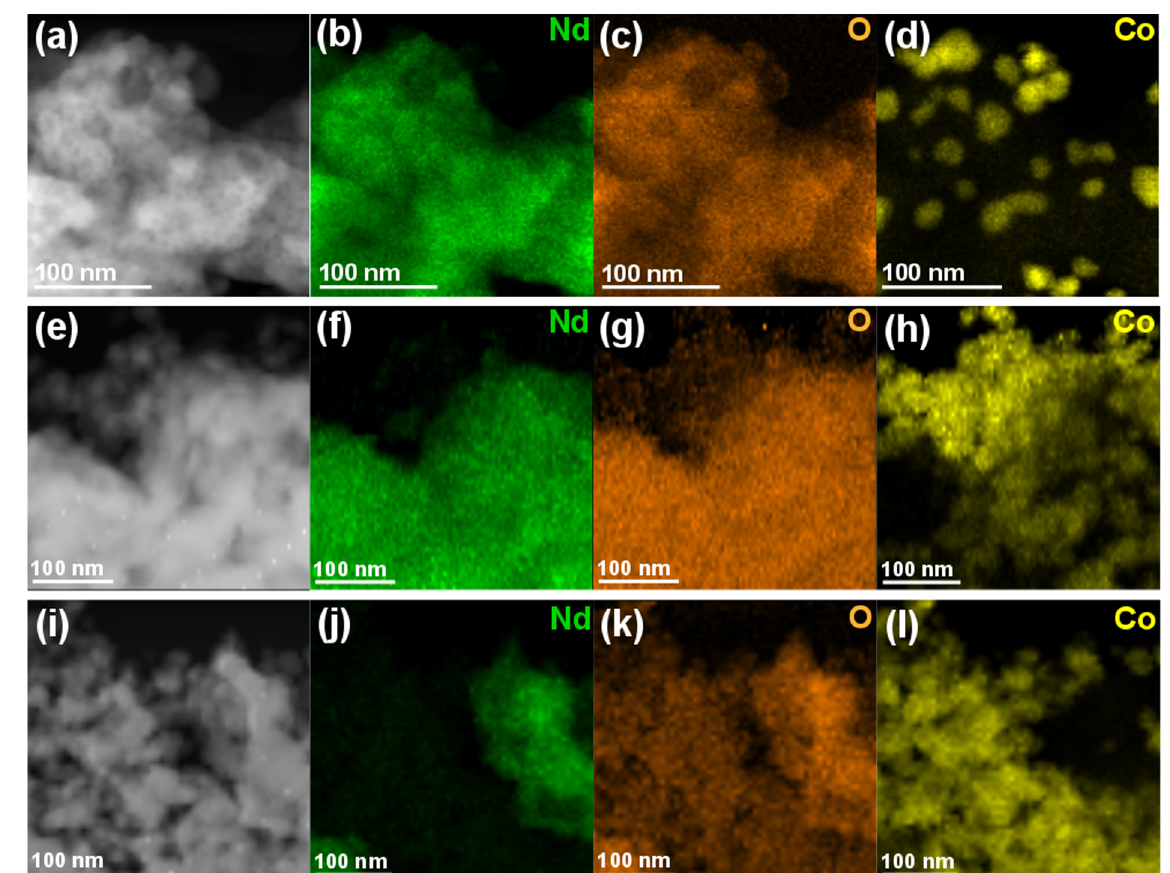
Figure 6. STEM images (first column) and corresponding elemental EDX mappings of the Co(10)/Nd 2 O 3 ( a – d ), Co(31)/Nd 2 O 3 ( e – h ), Co(50)/Nd 2 O 3 ( i – l ) catalysts, showing Nd (green), O (orange) and Co (yellow) concentrations.